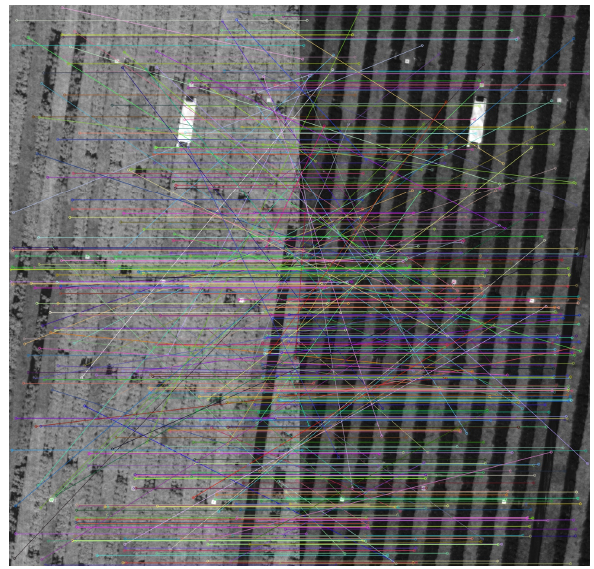
Figure 12. SIFT matches, including false matches, between reference band 31 (736.8nm, left) and band 1 (604.0nm, right).